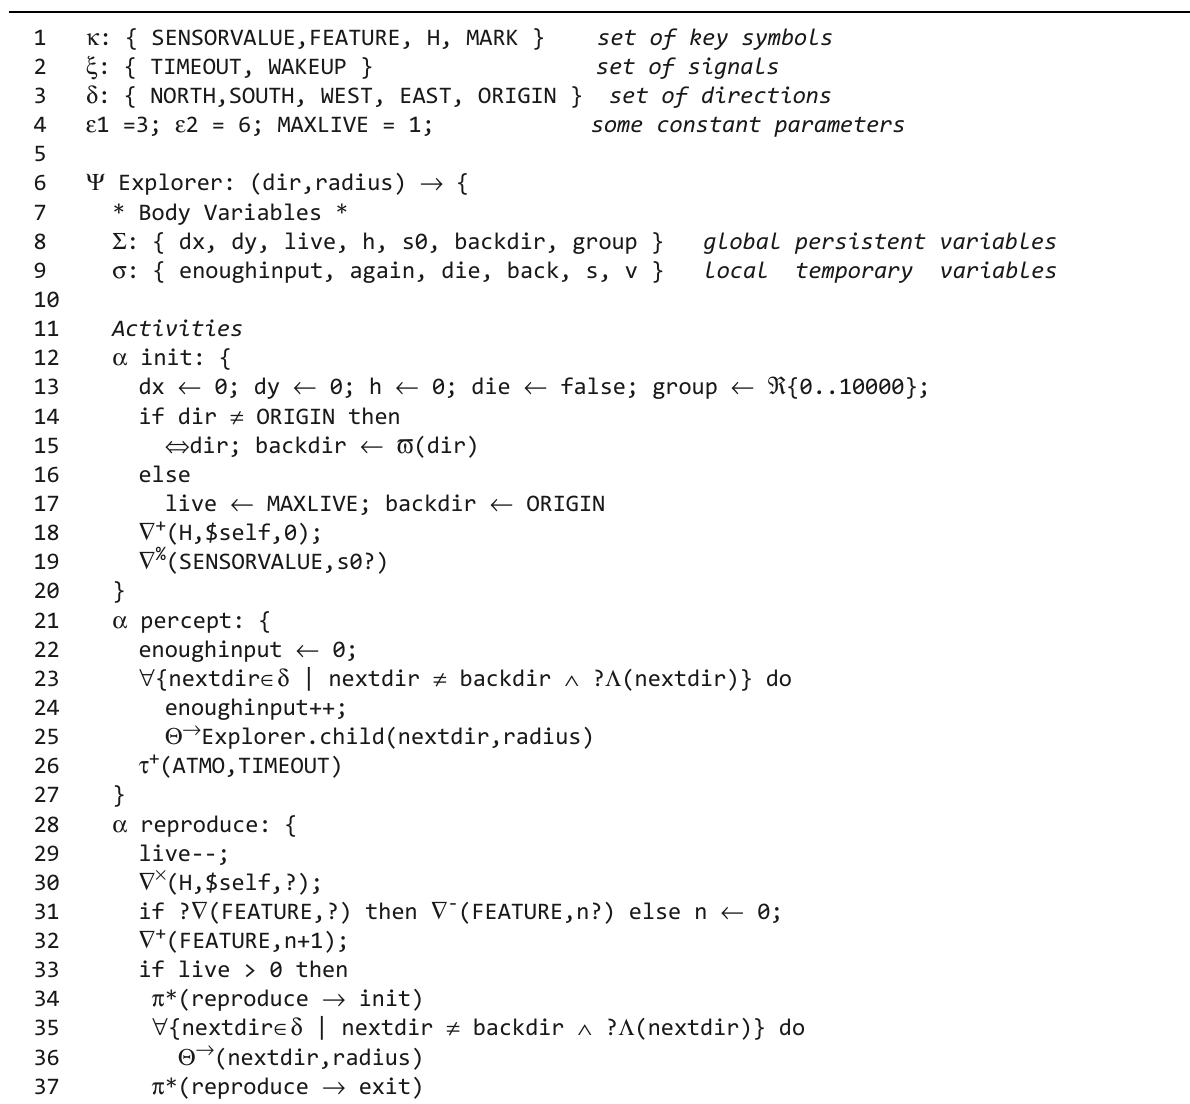
Algorithm 1 Definition of the explorer agent behavior class, including the explorer child